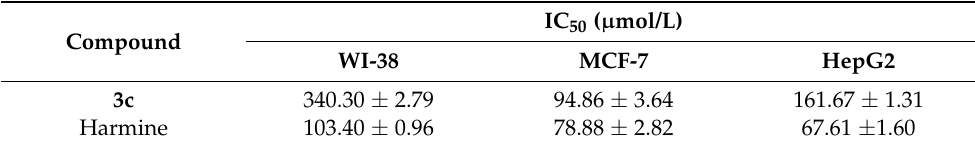
Table 2. Inhibition effect of target compounds in three cell lines. ( n = 3; Mean ± SD).